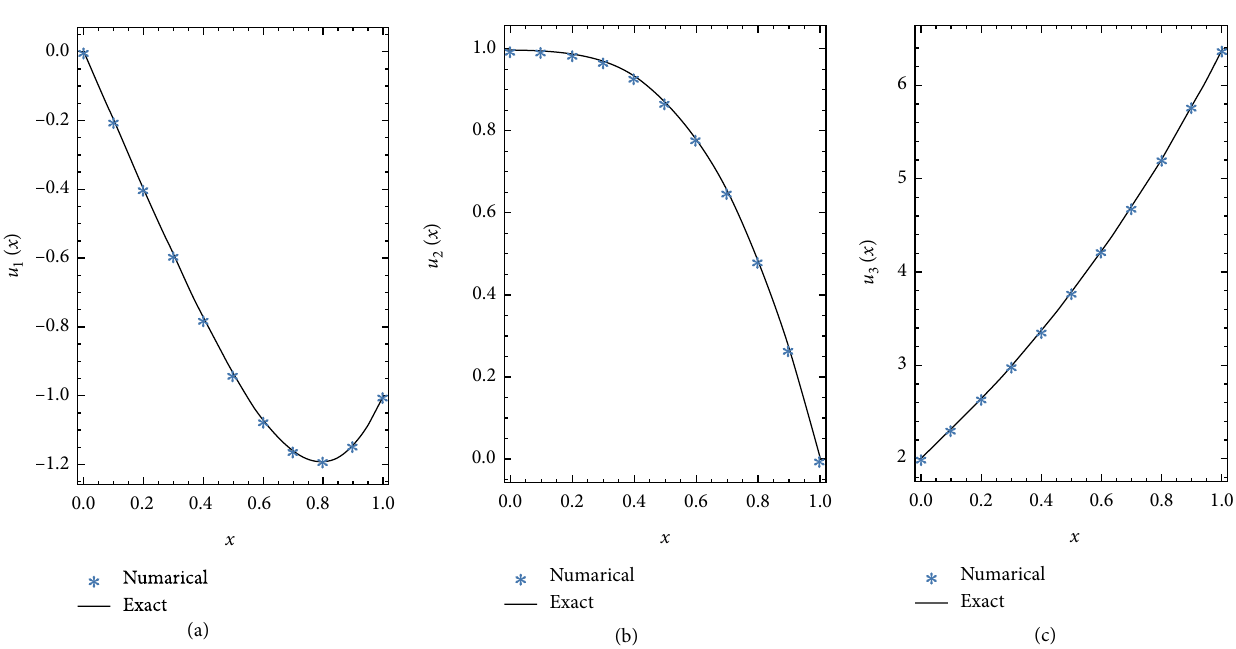
Figure 3: A comparison between exact and numerical solutions by applying Algorithm 2 for system (66) with . (b) The exact and numerical solutions of numerical solutions of 𝑢 1